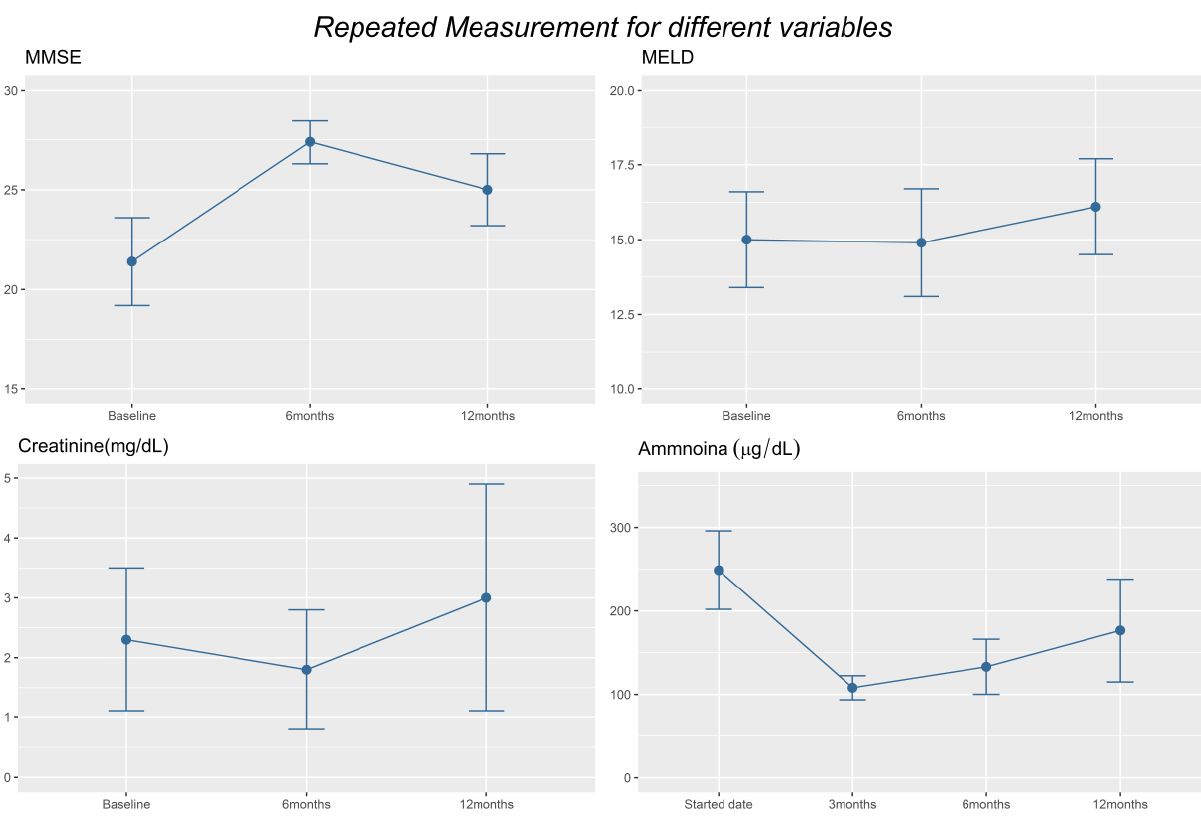
Table 4. Comparisons of clinical and laboratory parameters at baseline and after rifaximin plus lactulose initiated in patients (N = 12) during different follow-up